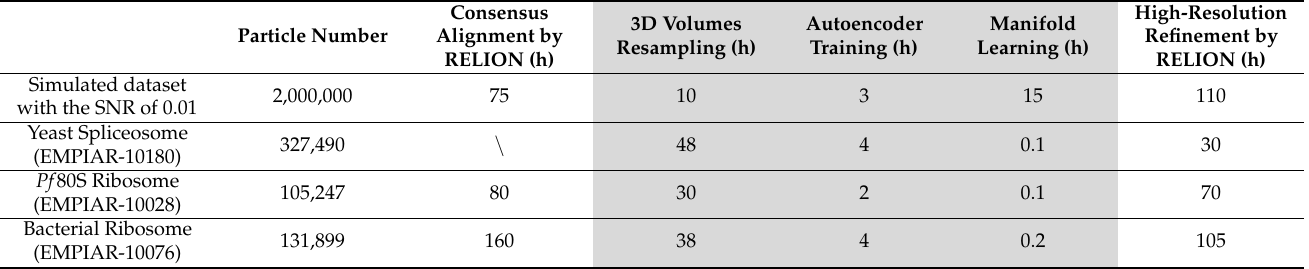
Table 4. Approximate computational time of AlphaCryo4D (grey boxes) on the simulated 2-million image dataset with the SNR of 0.01 and three experimental